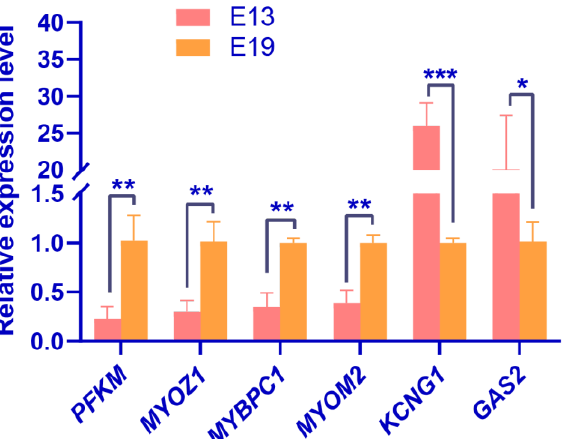
Figure 7. qRT-PCR validation of RNA-seq identification of the DEGs. In all panels, values are presented as the mean ± SEM. * p < 0.05; ** p < 0.01, *** p < 0.001.